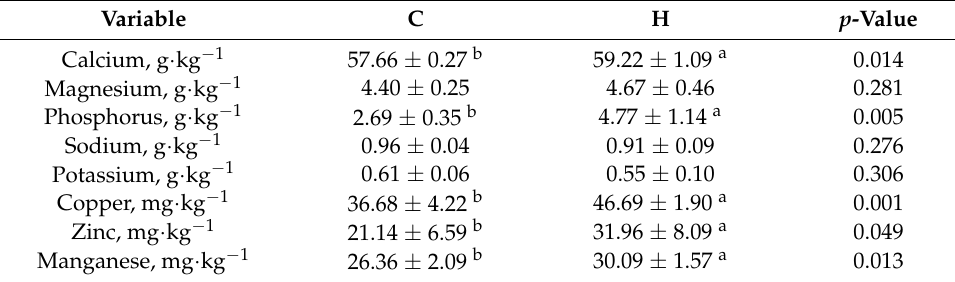
Table 5. The results of eggshell mineral analysis (means ± SD).